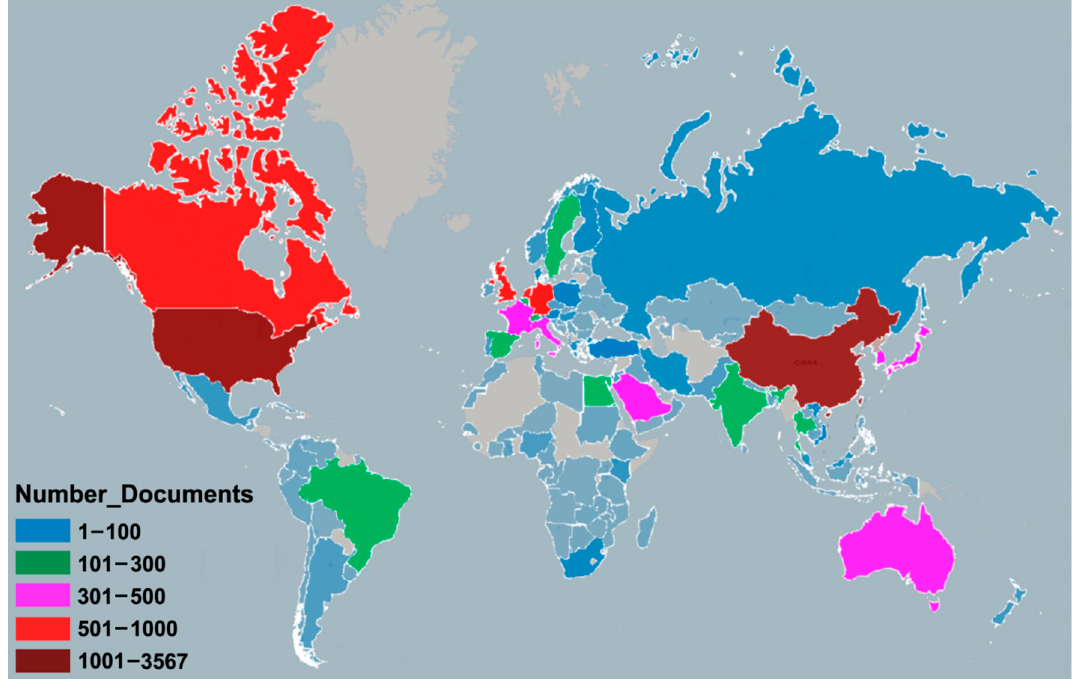
Figure 5. Geographical distribution of coronavirus publications. (Note: regions with no colors in the map have no available data).